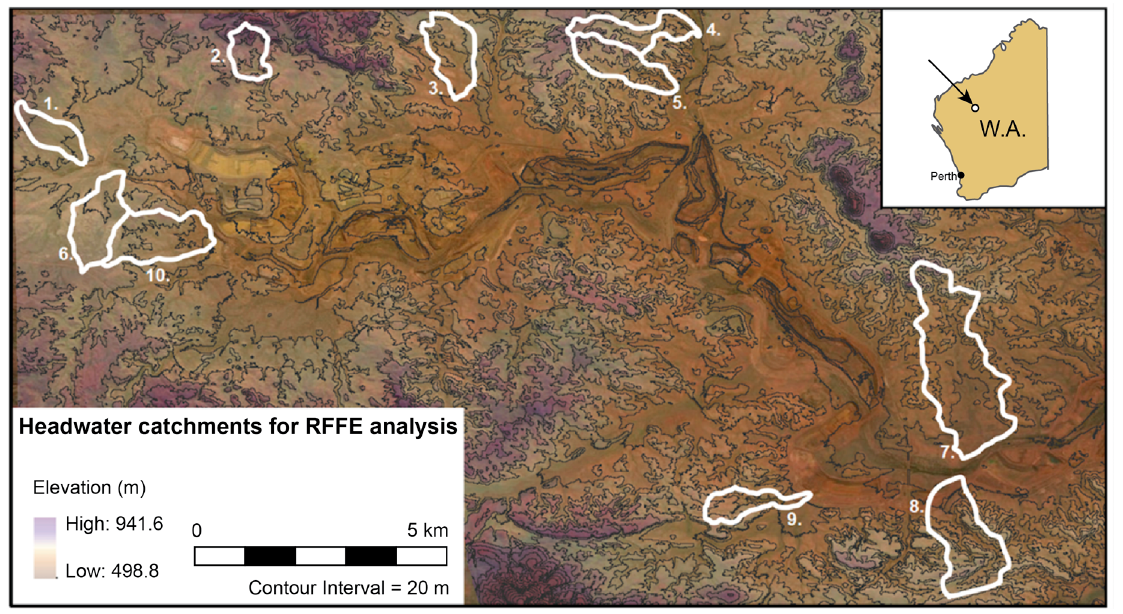
Figure 4. Map of headwater catchments used to test RFFE methods. Numbered catchments border the Yandi Mine in Eastern Pilbara, WA. Table 2. Catchment description for RFFE and direct rainfall analysis.